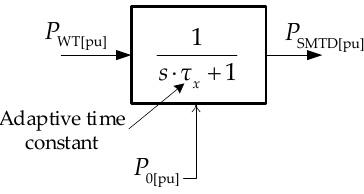
Figure 5. Varying transfer function block.